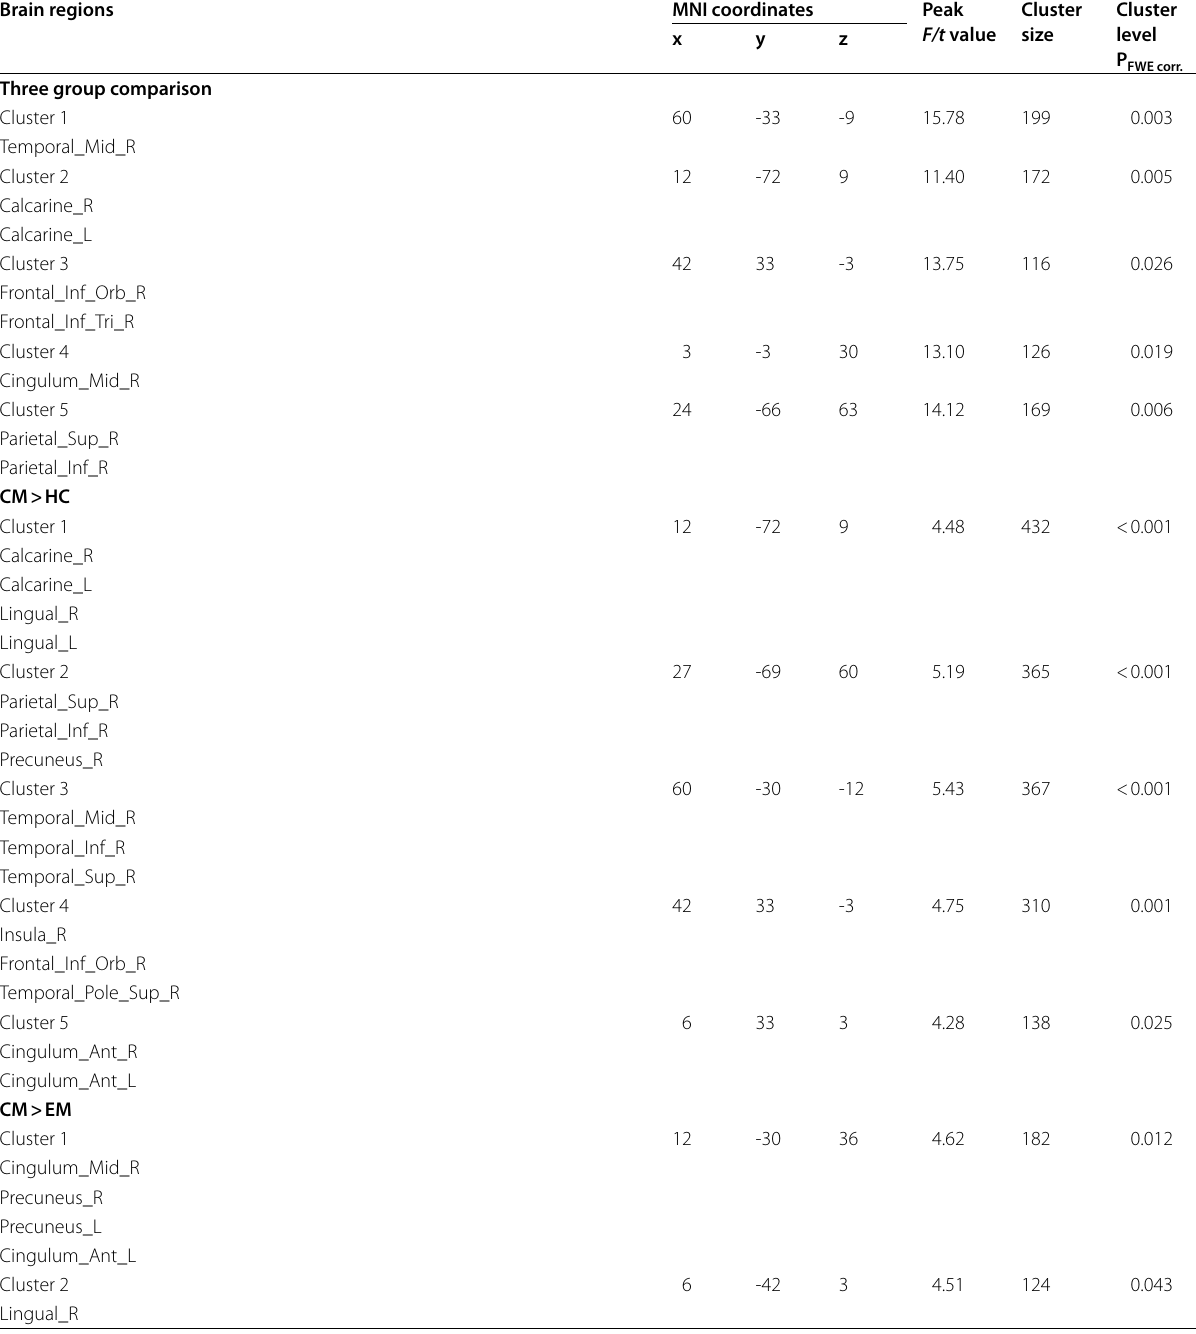
Table 3 Brain regions showing seed-based resting-state FC differences of right CN between CM and EM, HCs Brain regions MNI coordinates Peak